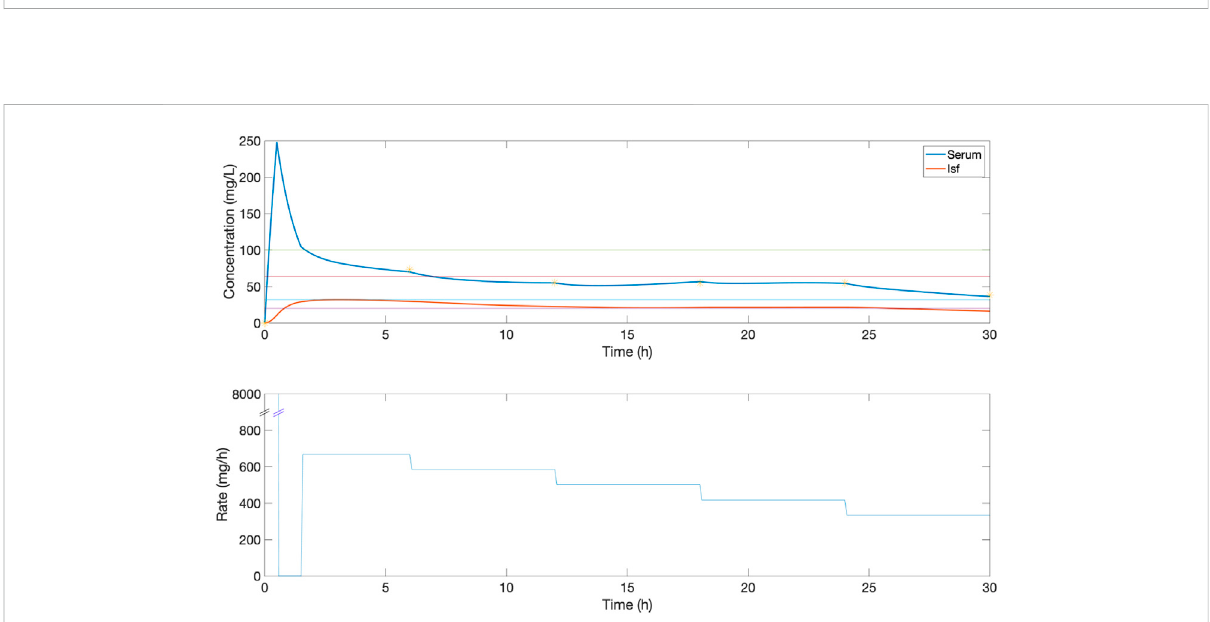
FIGURE 5 An example of the serum and ISF concentration (mg/L) of piperacillin and corresponding IV rate (mg/h) for an in silico patient dosed by comparisonprotocol3,wherealoadingdoseof4000 mgisfollowedbyacontinuousrateof4,000 mg/6 hwhichistitratedevery6 hby±500 mgif concentration was below or above the centre of target range 20 – 100 mg/L. Yellow stars show the value of measurements used to titrate, based on the 1 h delay. In this patient, dose titration improves serum time in the 32 – 64 mg/L evaluation range, with some variation within the